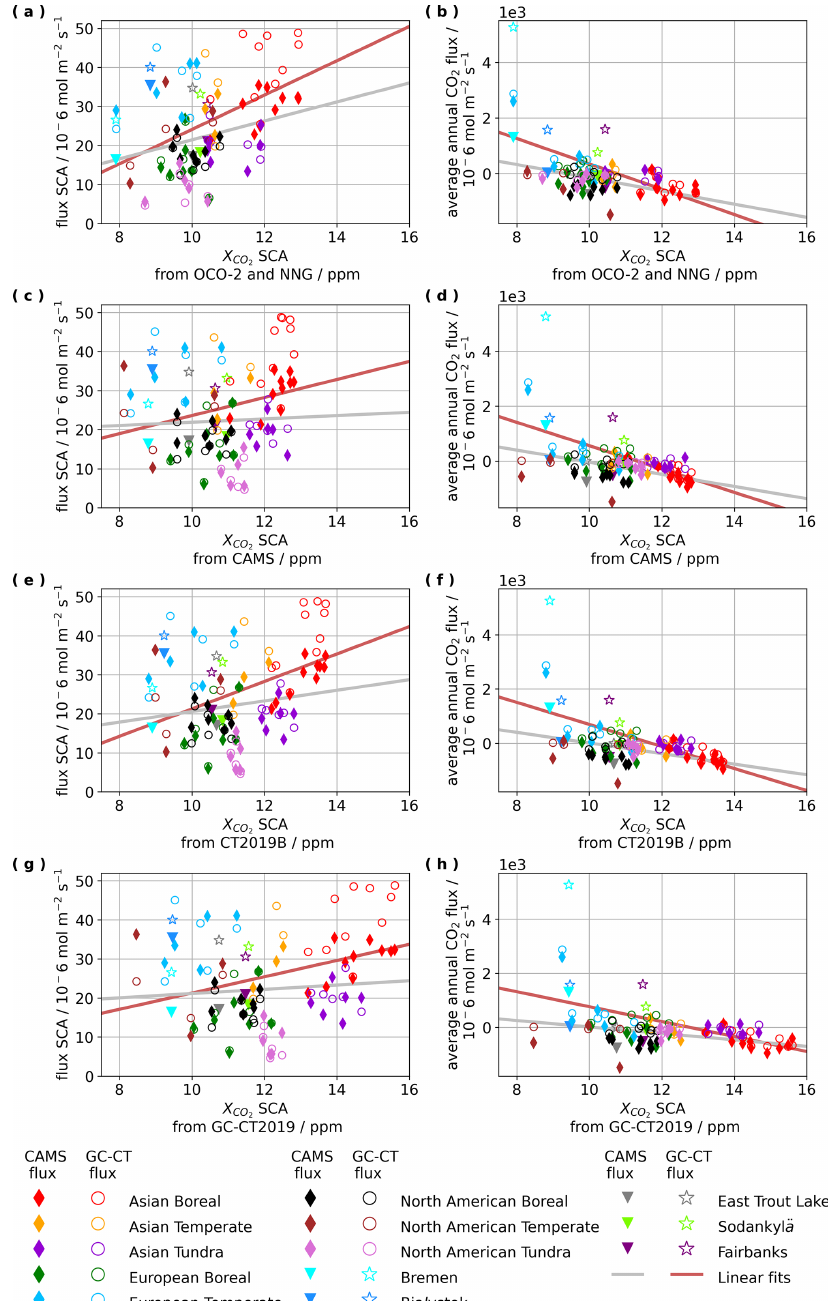
Figure 12. Correlation plots of flux SCA and average annual fluxes from CAMS and GC-CT2019 versus X CO as well as model-derived X CO SCA from CAMS, CT2019B, and 2